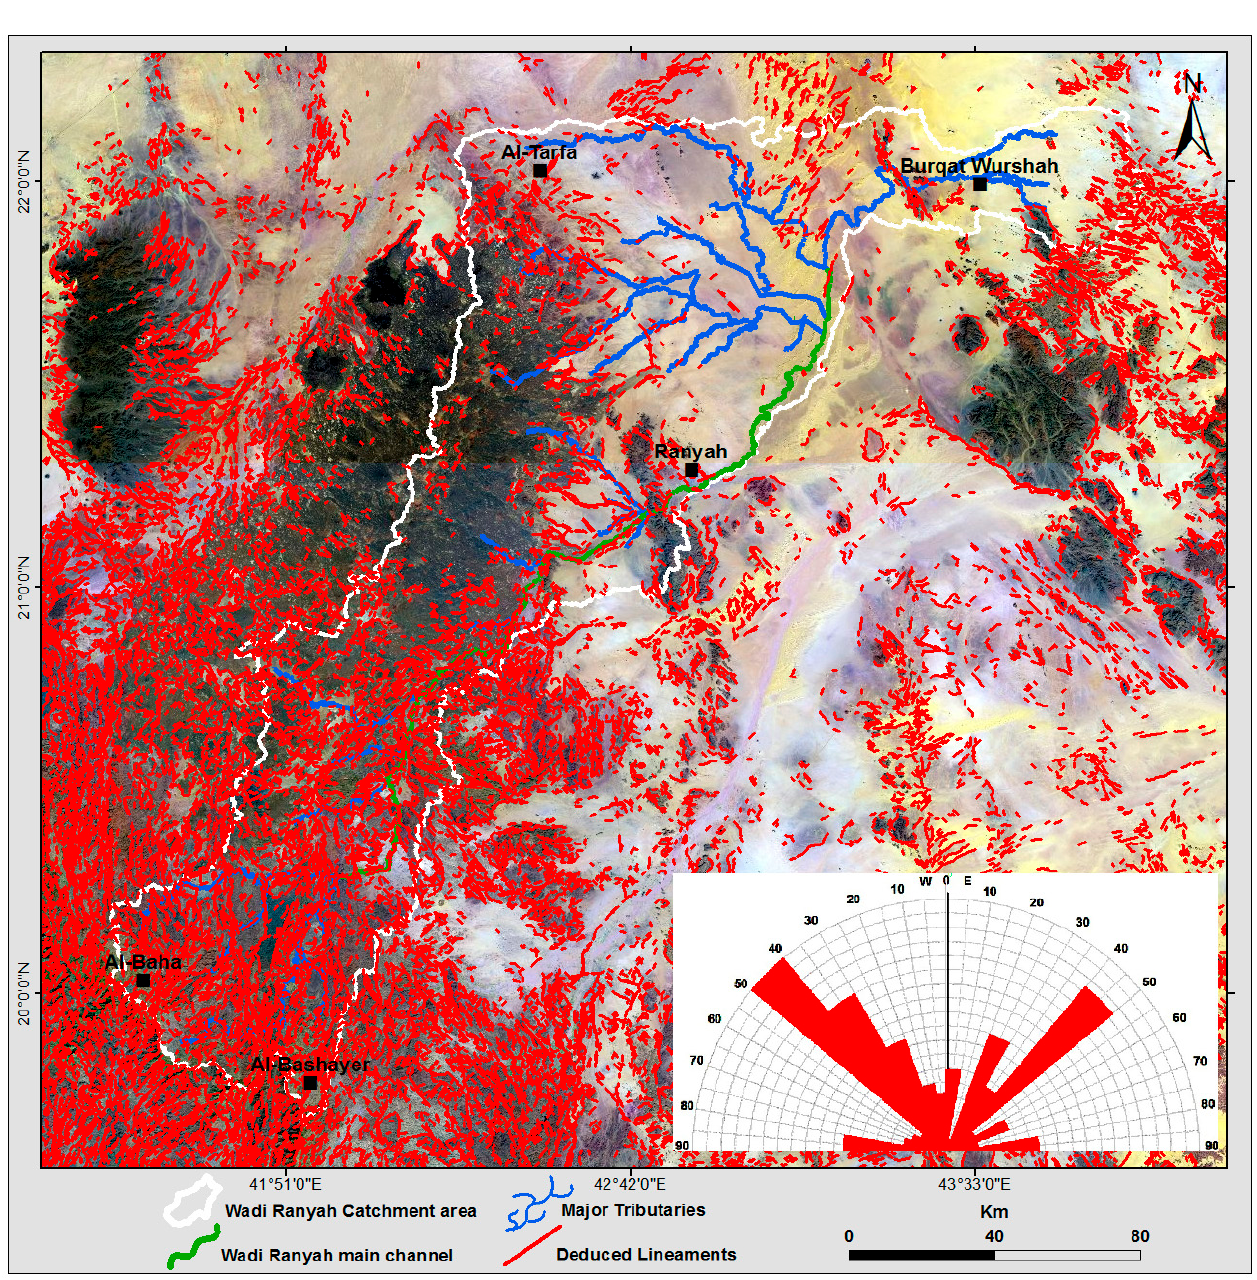
Figure 14. The surface lineaments traced from the Landsat images and its rose diagram for the study study region.